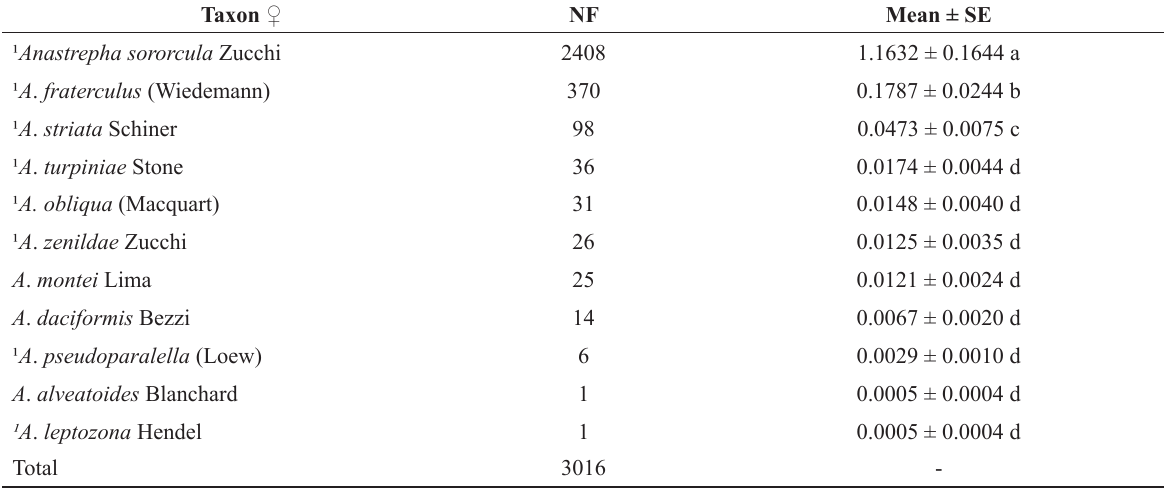
Multiple comparison between adults of pest species of Anastrepha spp. (Diptera: Tephritidae) in guava